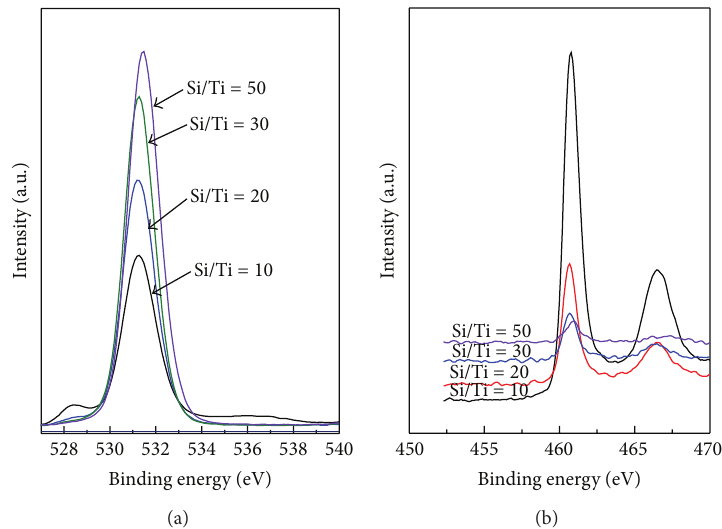
Figure 4: XPS spectra of different titanium content of Ti-SBA-15: (a) O1s core-level spectra and (b) Ti2p core-level spectra.